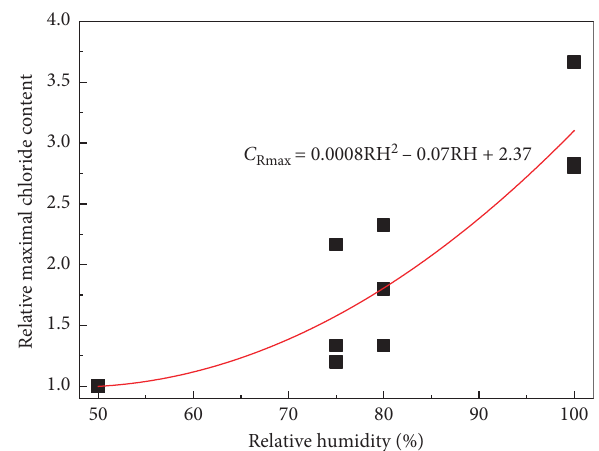
Figure 6: Relationship between the relative maximum chloride content and internal RH of